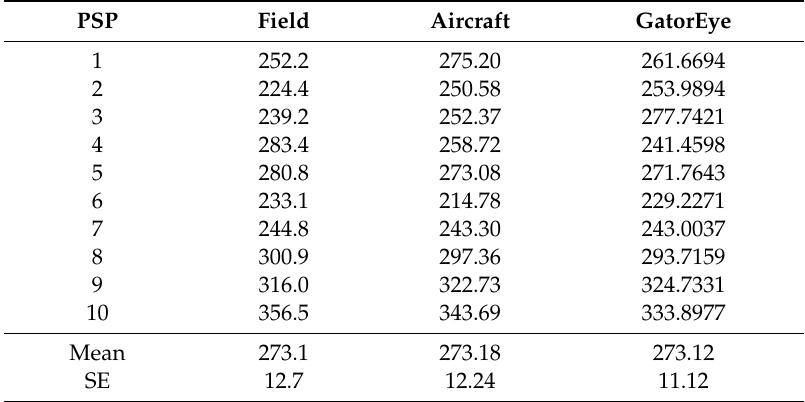
Table 6. Aboveground biomass estimates (AGB; Mg · ha − 1 ) produced by the LiDAR models and field measurements for each Permanent Sample Plot